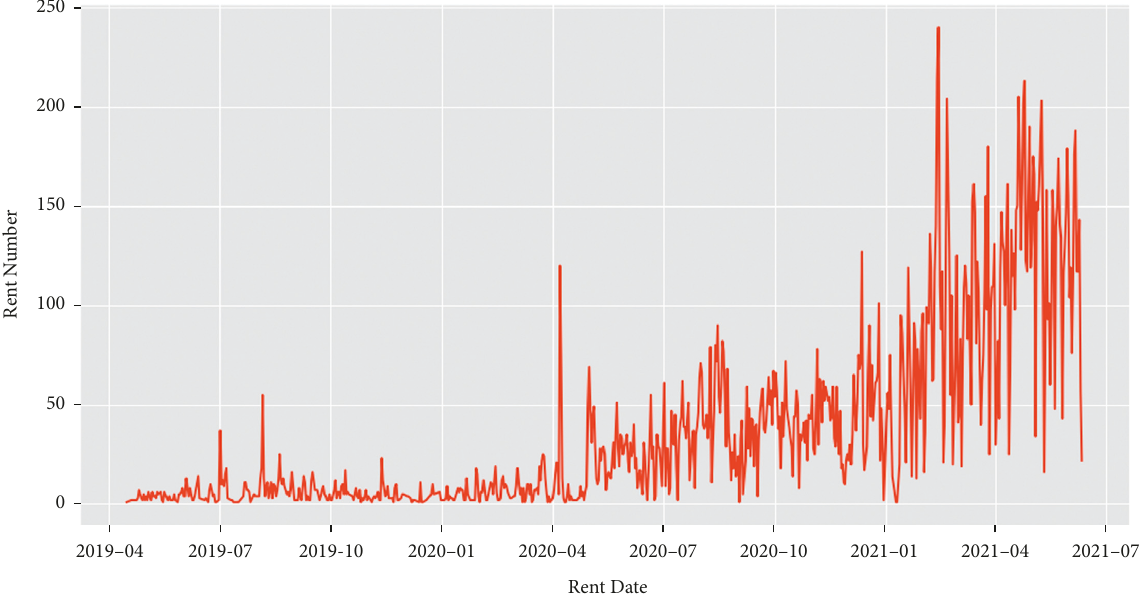
Figure 6: Daily demand for electric kickboards.